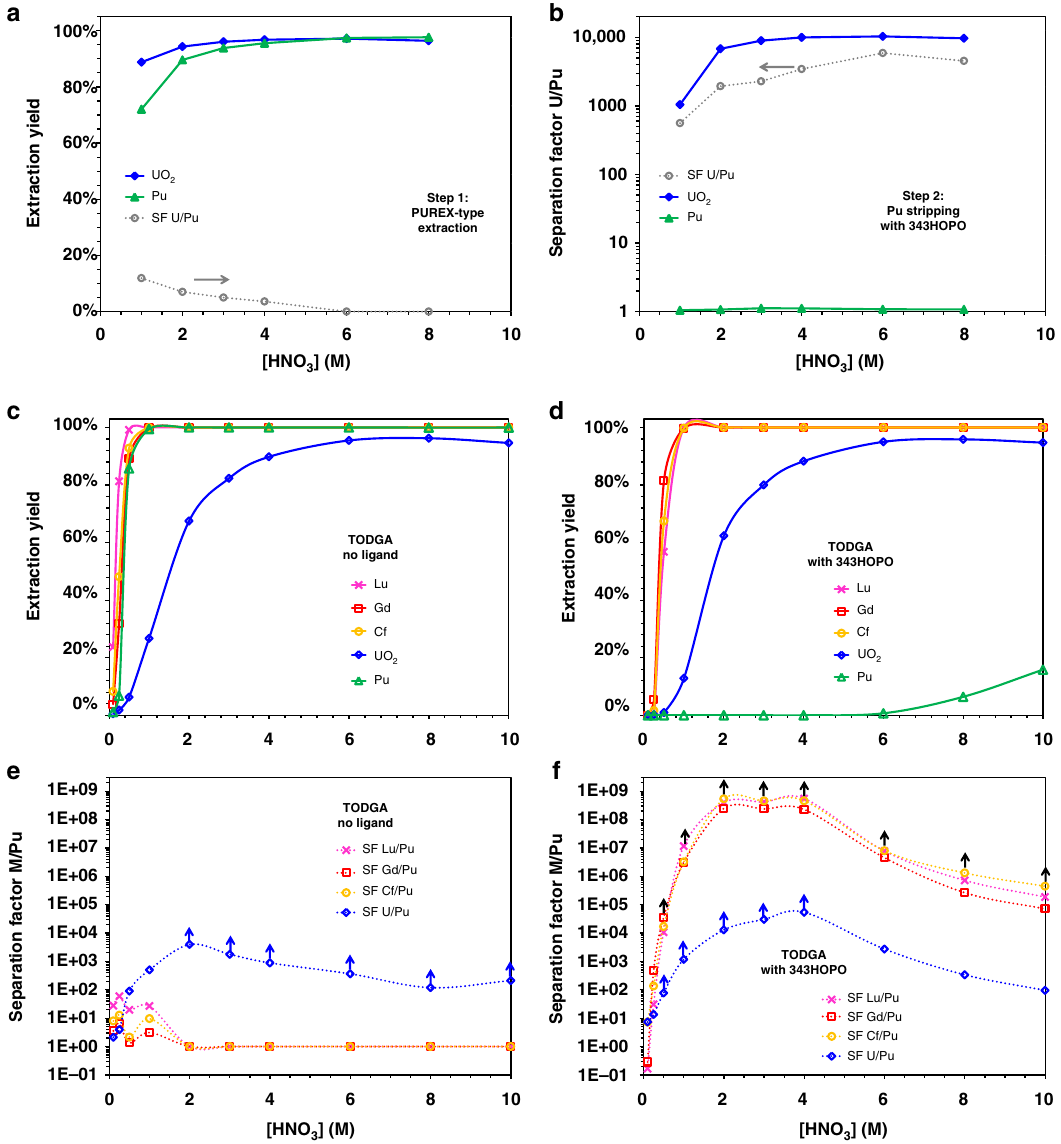
Fig. 4 Separation of Pu from U, Gd, Lu, and Cf. Extraction of Pu 4 + (triangles) and UO 2 2 + (diamonds) under typical PUREX conditions ( a ) and back- extraction in the presence of 1 mM 343HOPO ( b ). Dotted lines: separation factor U/Pu. Organic phase: 30 % TBP in kerosene. c and d show the extraction yields of Gd 3 + (squares), Lu 3 + (crosses), Cf 3 + (circles), UO 2 2 + , and Pu 4 + by TODGA in the absence or presence of 1 mM 343HOPO, respectively. Corresponding separation factors are given in e and f . Organic phase: 0.1 M TODGA in kerosene. Aqueous solvent: HNO 3 . T = 25 °C. O/A = 1, one contact. Points with arrows are lower